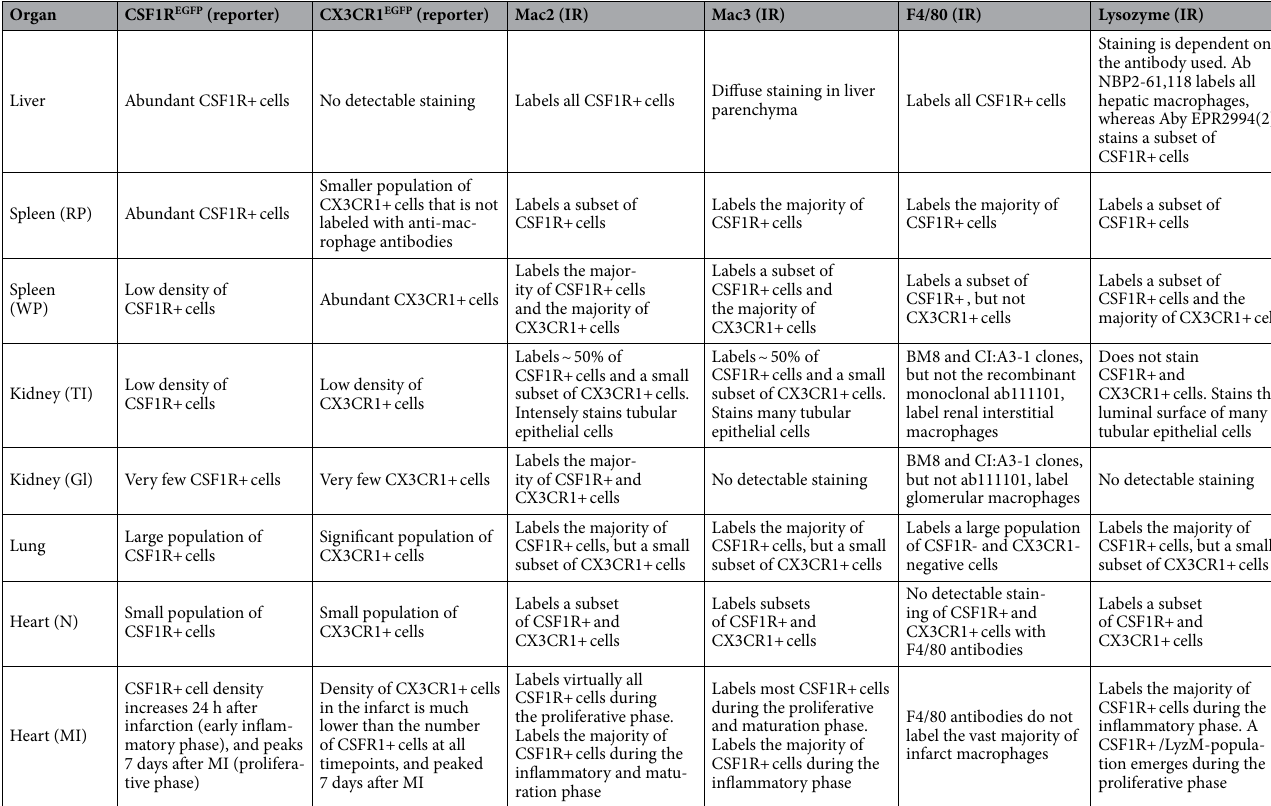
Table 2. Patterns or macrophage labeling in formalin-fixed paraffin-embedded mouse organs using reporter lines and antibodies. Ab, antibody; IR, immunoreactivity; RP, red pulp; WP, white pulp; TI, tubulointerstitium; Gl, glomerular; N, normal; MI, myocardial